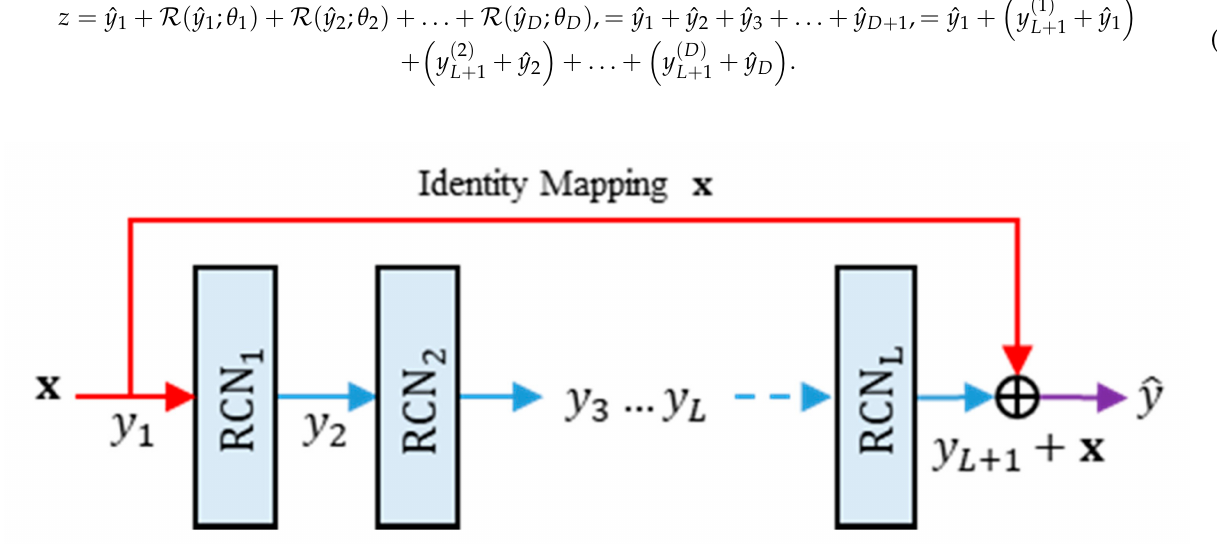
Figure 7. The architecture of residual networks of residual concatenated network